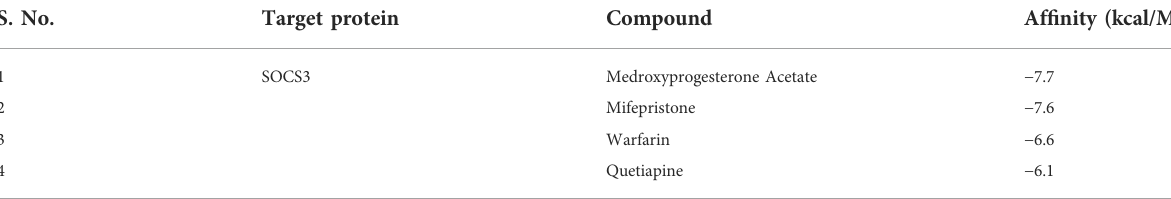
TABLE 3 Table representing binding af fi nity and inhibition constant for the interaction of four drugs with SOCS3. S.